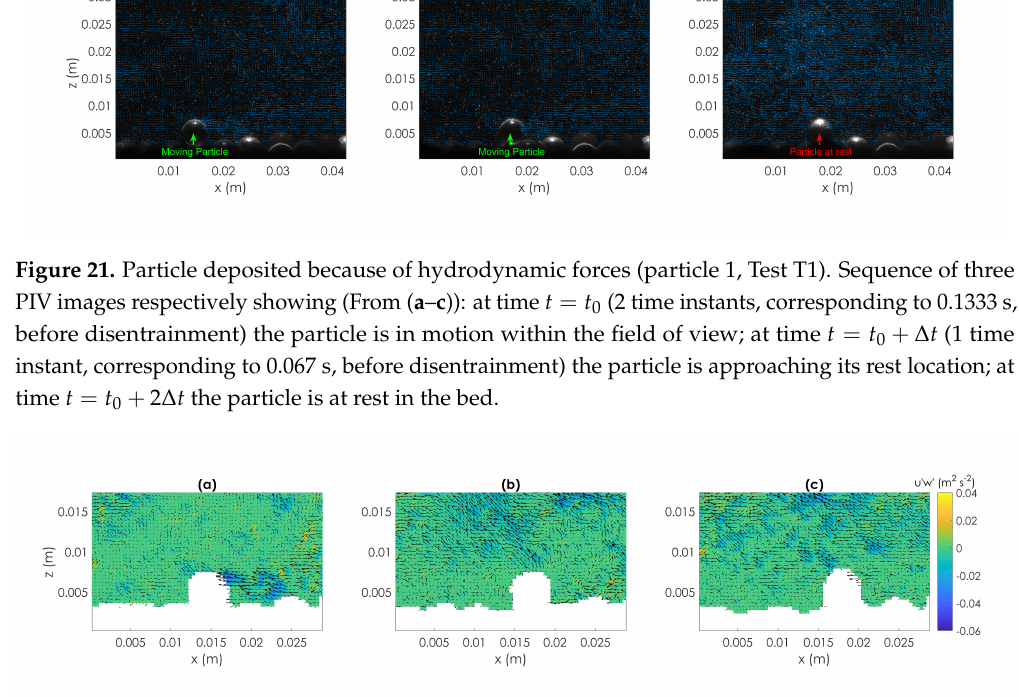
Figure 22. Instantaneous Reynolds shear stress maps with vectors superimposed representing velocity fluctuations obtained for disentrainment event number 1-Test T1 for the sequence of three PIV images reported in Figure 21. ( a ) the moving particle starts decelerating and a ejection event is observed downstream of the particle location. ( b ) The ejection event has passed and particle approaches its rest locatin. ( c ) The particle is at